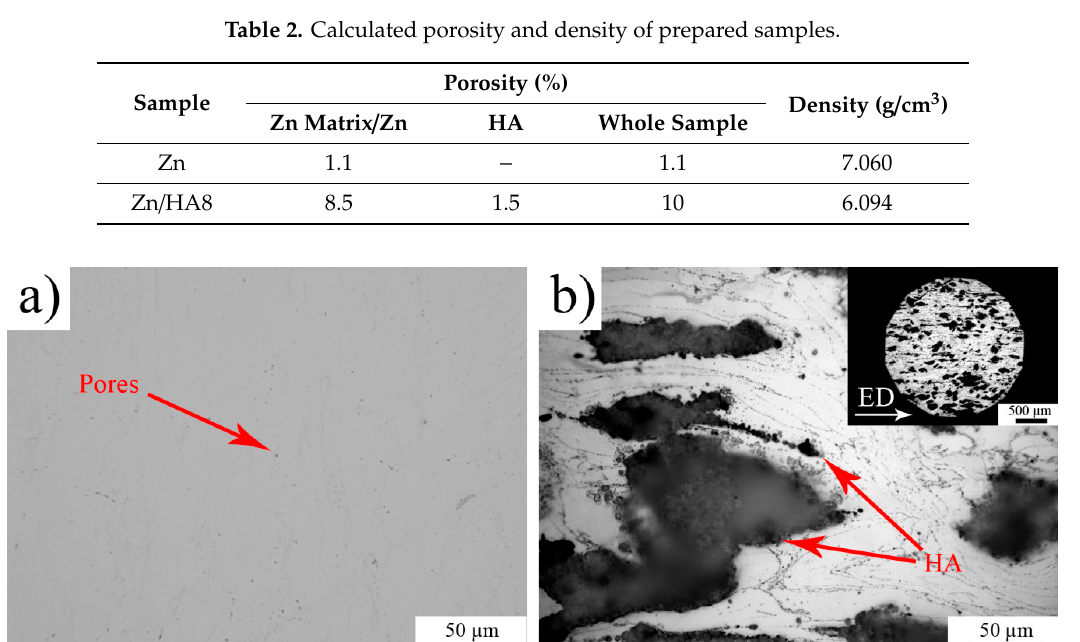
Table 2. Calculated porosity and density of prepared samples.